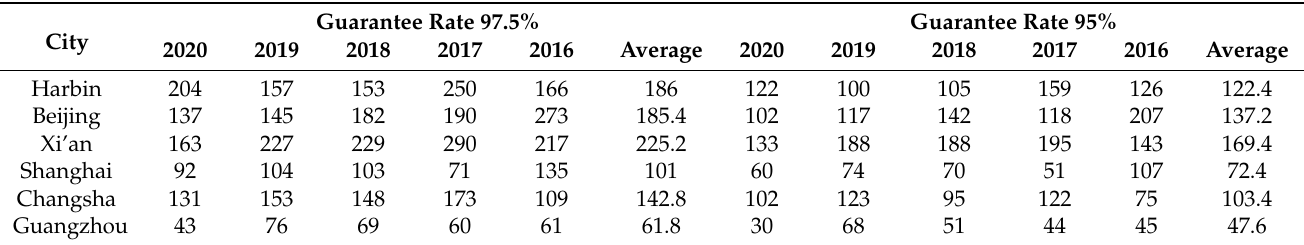
Table 3. The outdoor PM 2.5 design concentrations corresponding to different guarantee